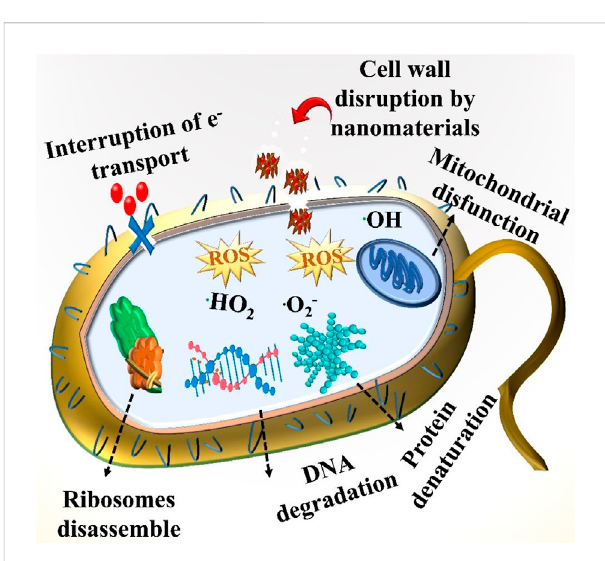
FIGURE 10 Antibacterial action mechanism of synthesized